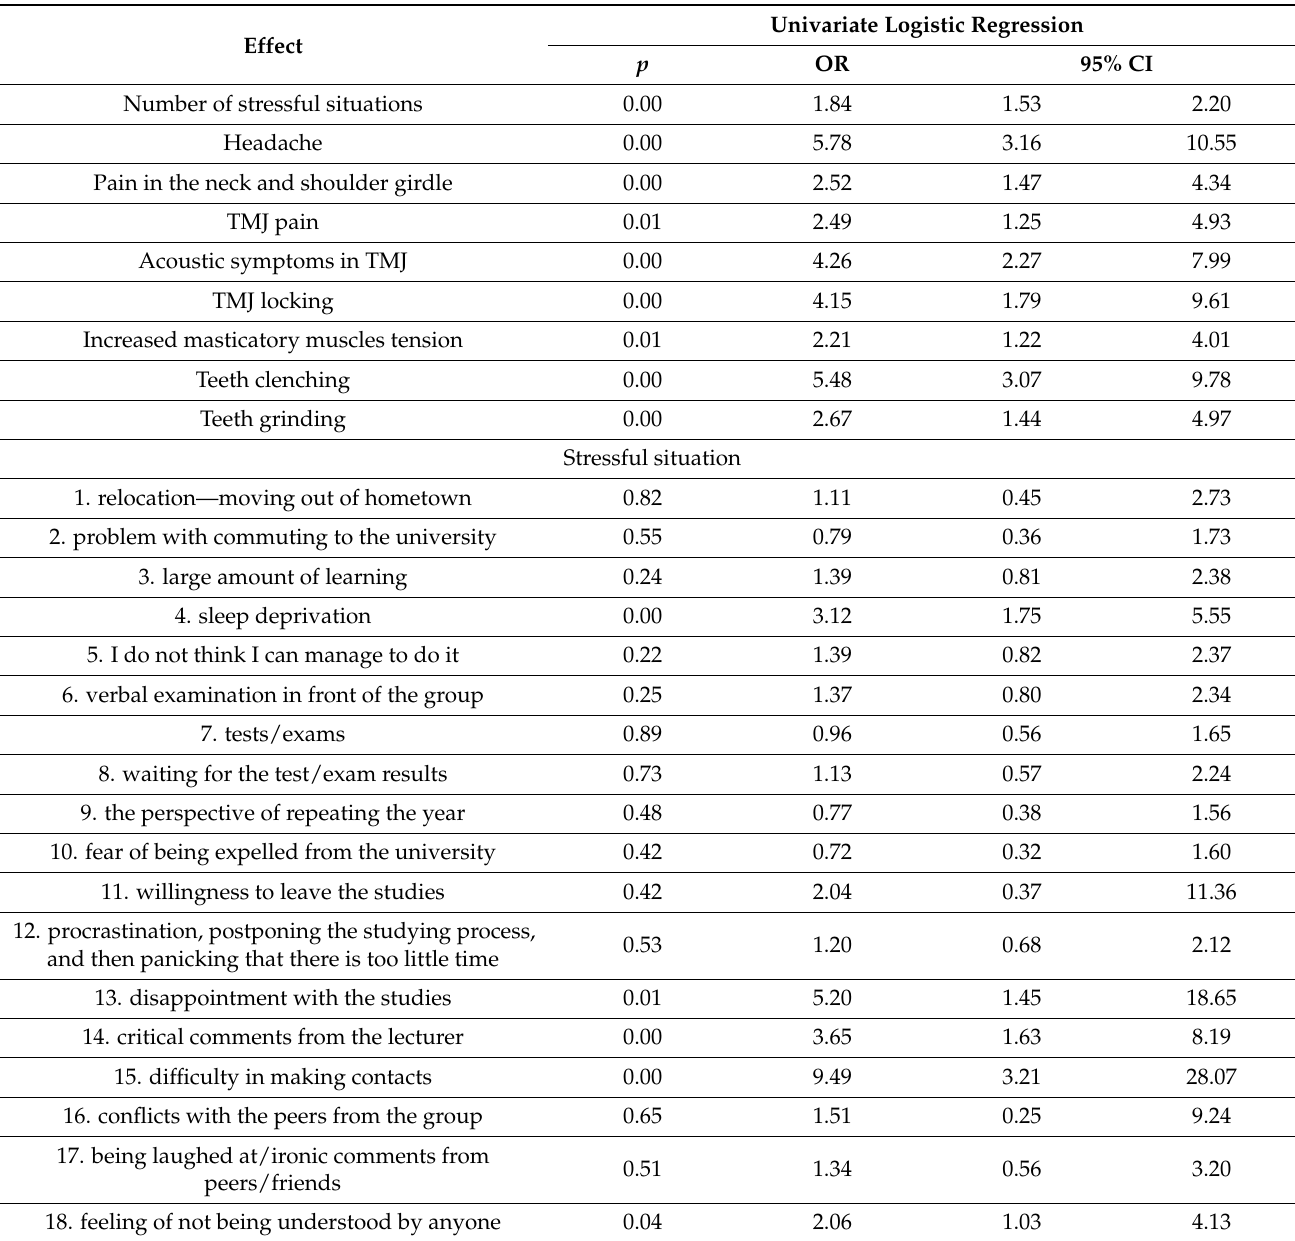
Table 5. Univariate logistic regression analysis as regards the presence of the D